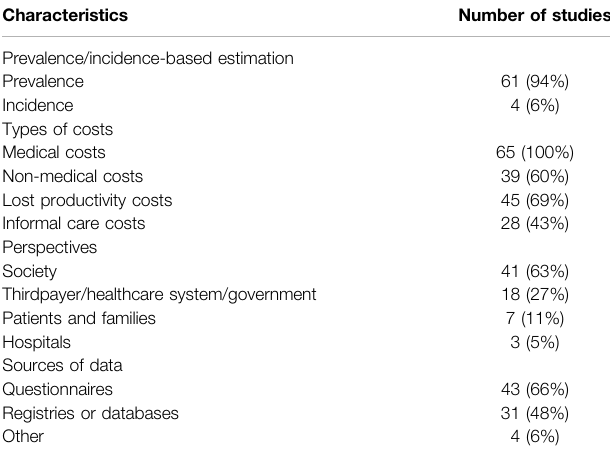
TABLE 1 | Characteristics of the 65 reviewed COi